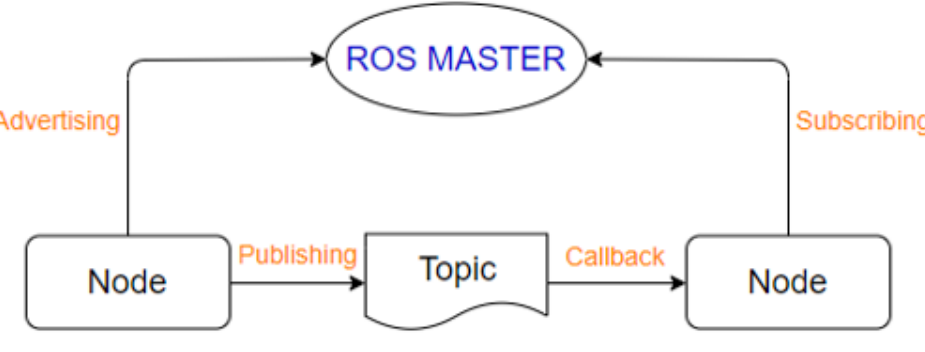
Figure 5. Component system of a ROS